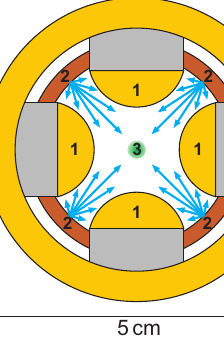
Figure 1. Radial cross section of